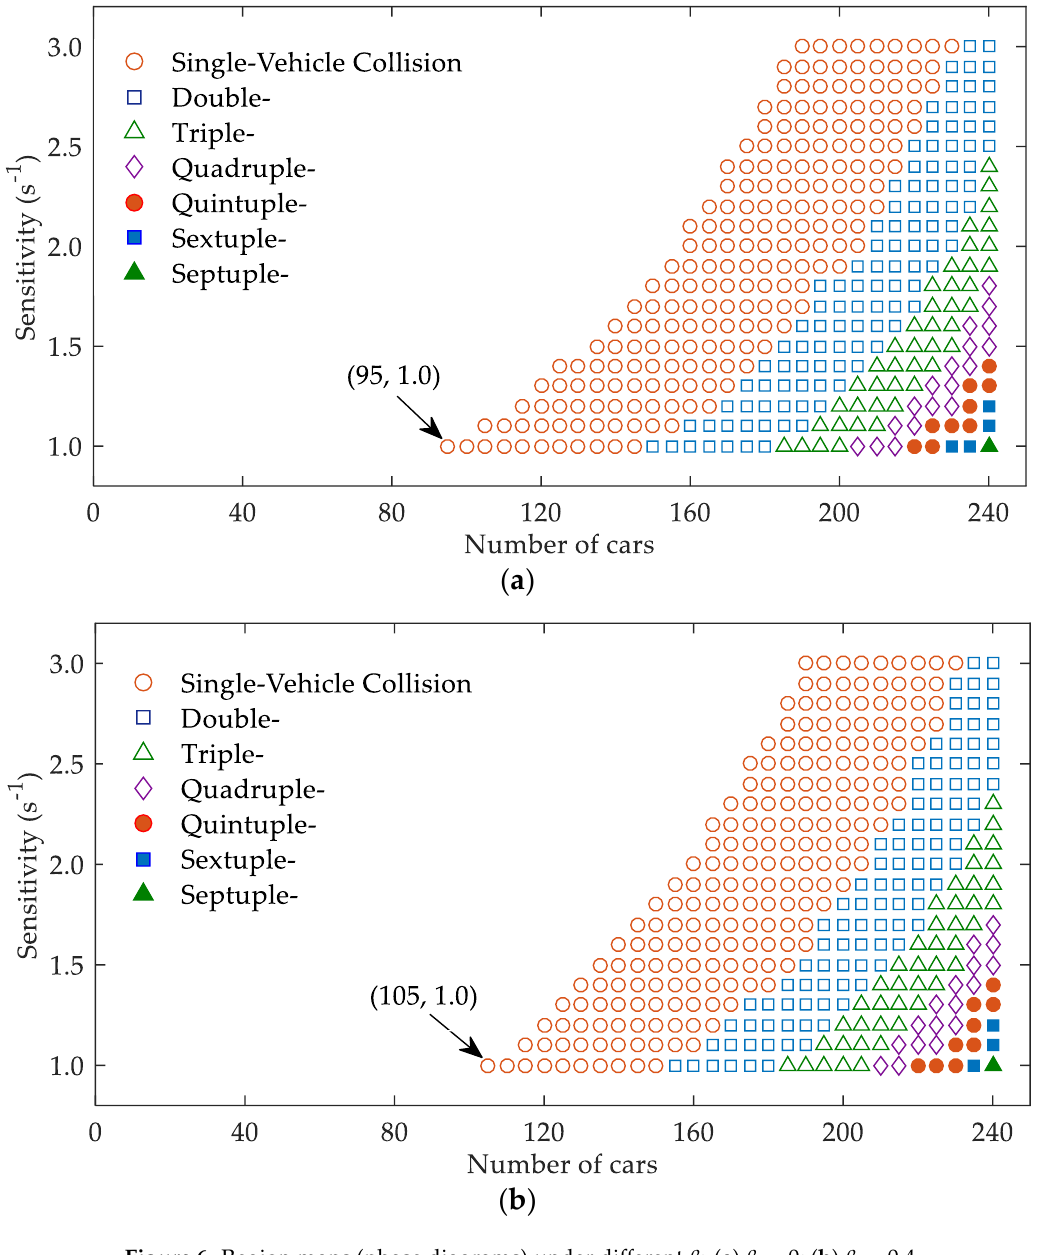
Figure 6. Region maps (phase diagrams) under different β : ( a ) 0 β ; ( b ) 0.4 β .